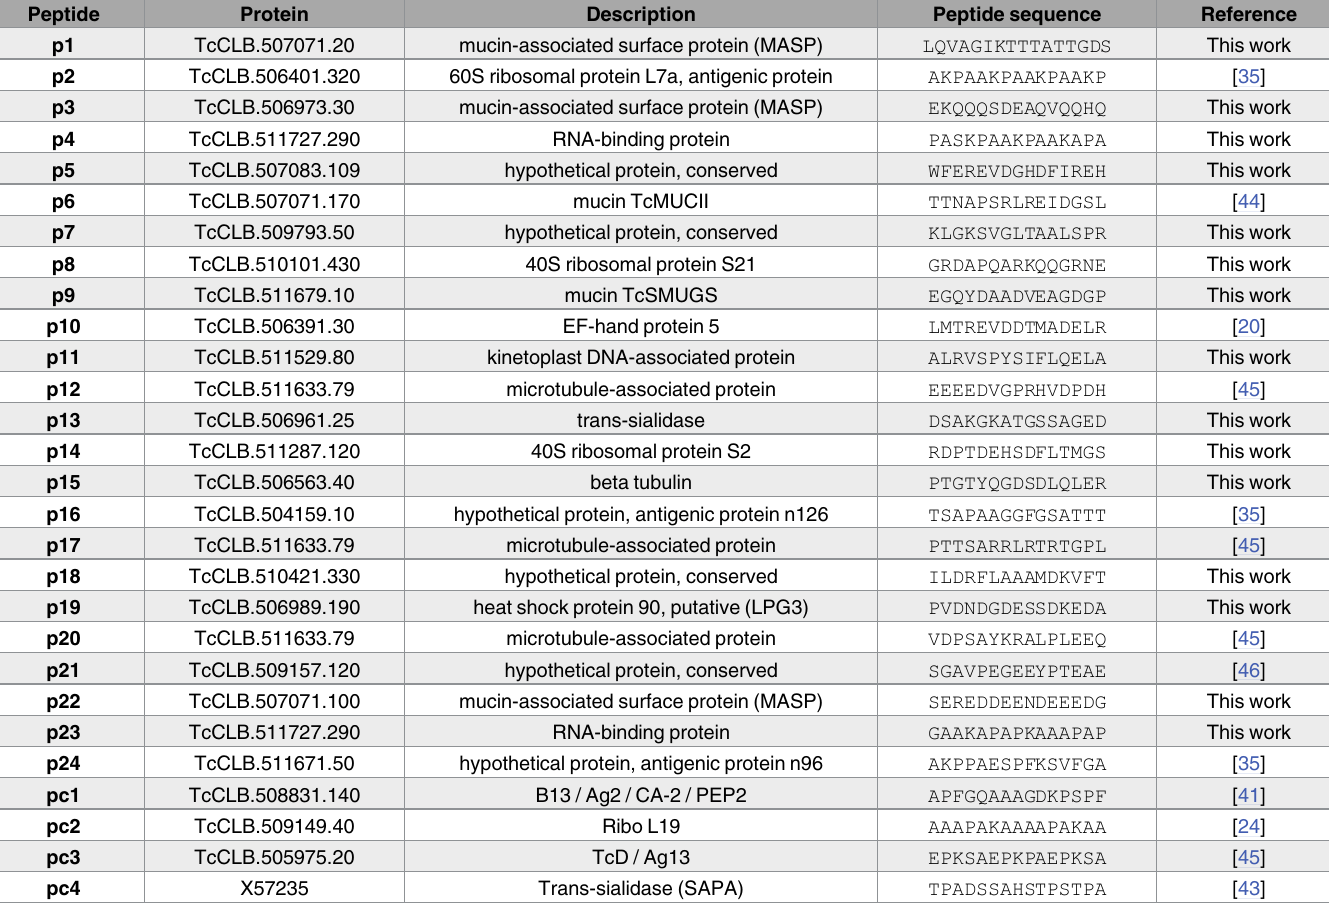
Table 1. Sequence and featuresof synthetic peptides evaluated in this work. Bibliographic referencesare providedfor the most relevant publication where the correspondingepitopehas been mapped,or the protein has beenvalidatedas a human antigen. Peptide